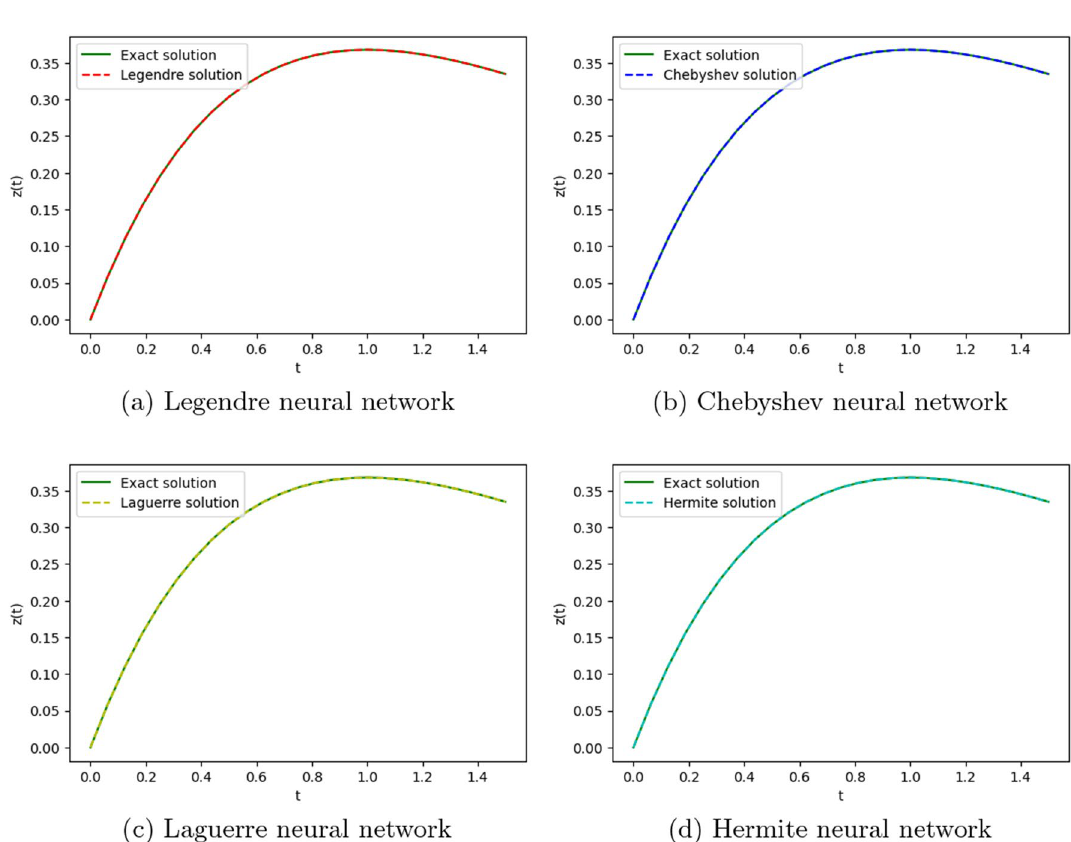
Figure 2. Comparison of the exact solution with the obtained approximate solutions of Example